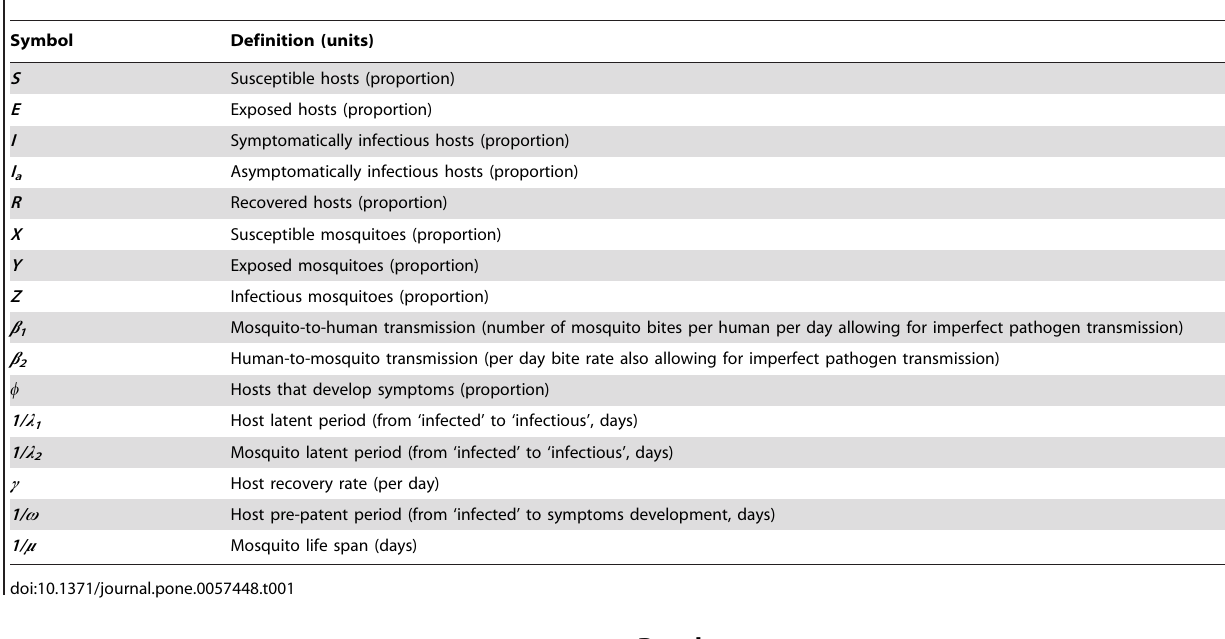
Table 1. The parameters and variables (with units) of the Chikungunya model.